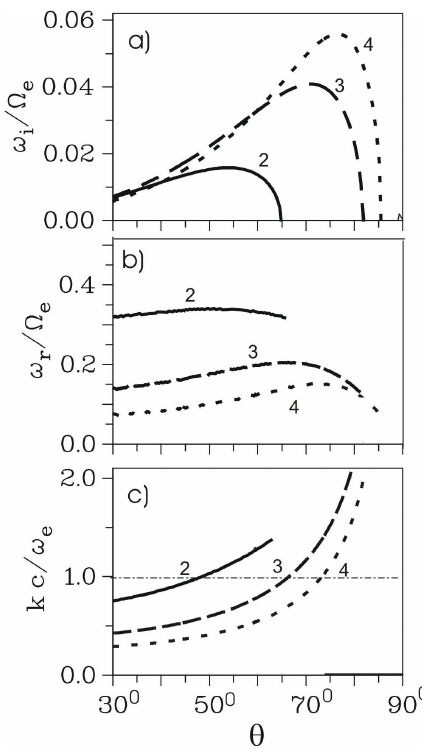
Fig. 3. From top to bottom: (a) Maximum growth rate, (b) related (real) frequency and (c) wave number versus the propagation angle θ , for different beam velocities (in units of V Ae ). The beam density is n b /n po = 0 . 01. Note that the wave number for maximum growth rate is at kc/ω e ≈